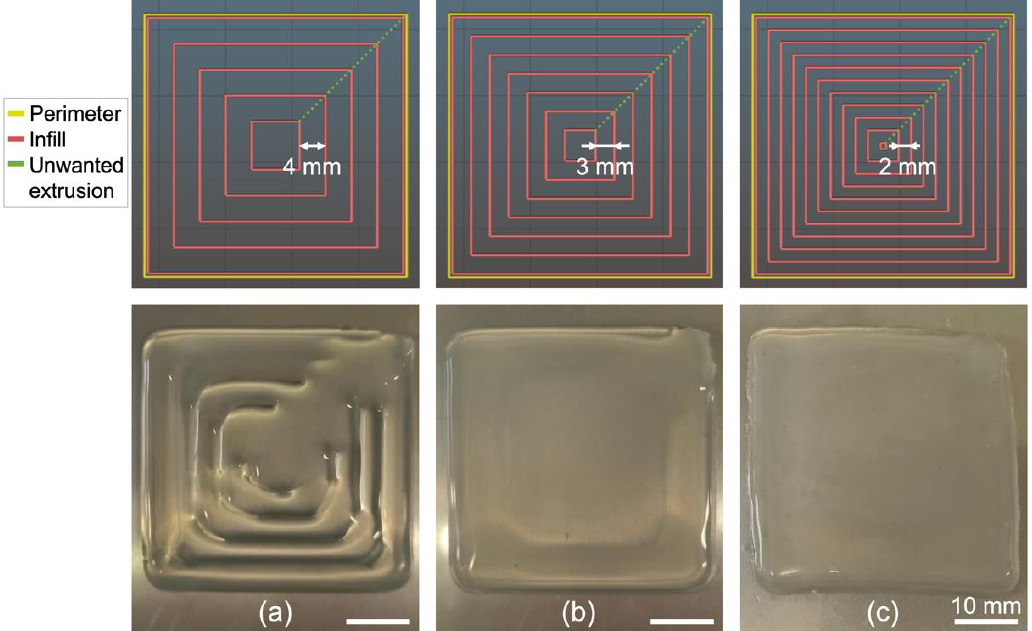
Figure 6. Tests to determine the optimal distance between infill lines in the case of a 40 mm × 40 mm square with a concentric infill pattern. ( Top ) Printing paths generated in Slic3r. ( Bottom ) Corre- sponding prints for ( a ) 13% infill density (4 mm line separation); ( b ) 18% infill density (3 mm line separation); and ( c ) 27% infill density (2 mm line separation). Silicone: Ecoflex 00 - 20. Needle diam- eter: 1.6 mm. Printing speed: 30 mm/s. Extrusion speed: 0 mm/s. Bed temperature: 90 °C.